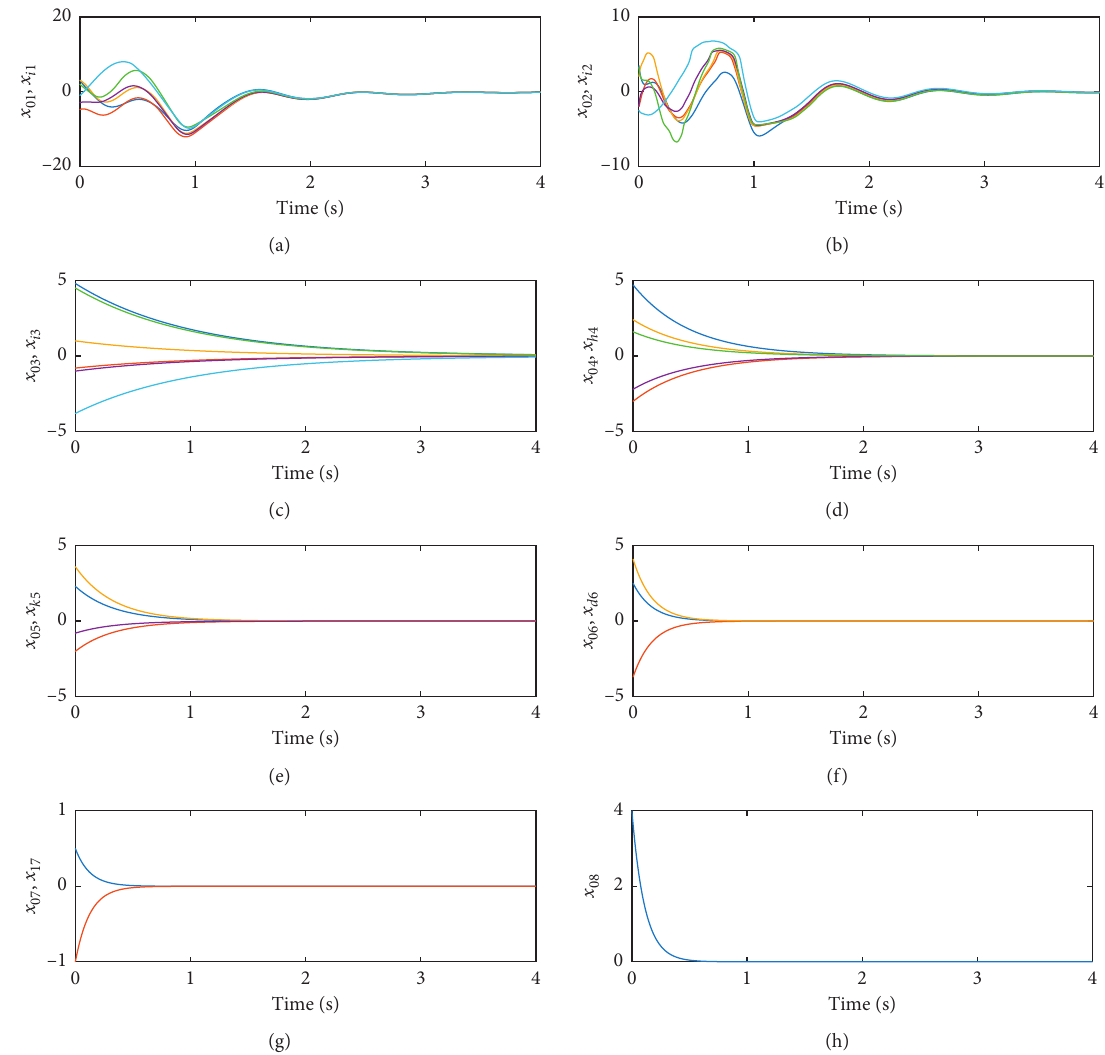
Figure 3: Trajectories of the states of leader x